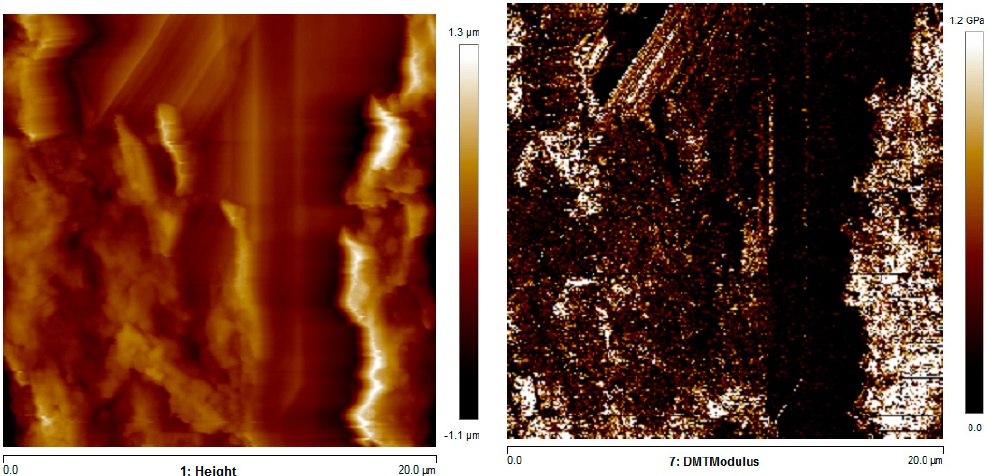
Figure 11. AFM height and elastic modulus maps of the specimens C.